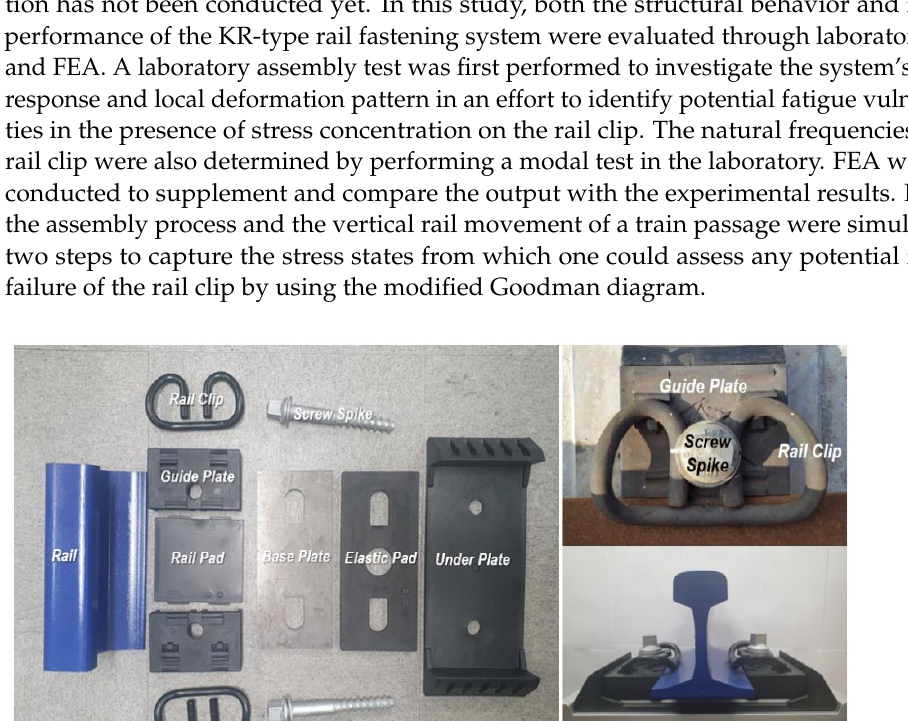
Figure 2. The KR-type rail fastening system: ( a ) components; ( b ) assembled configuration.